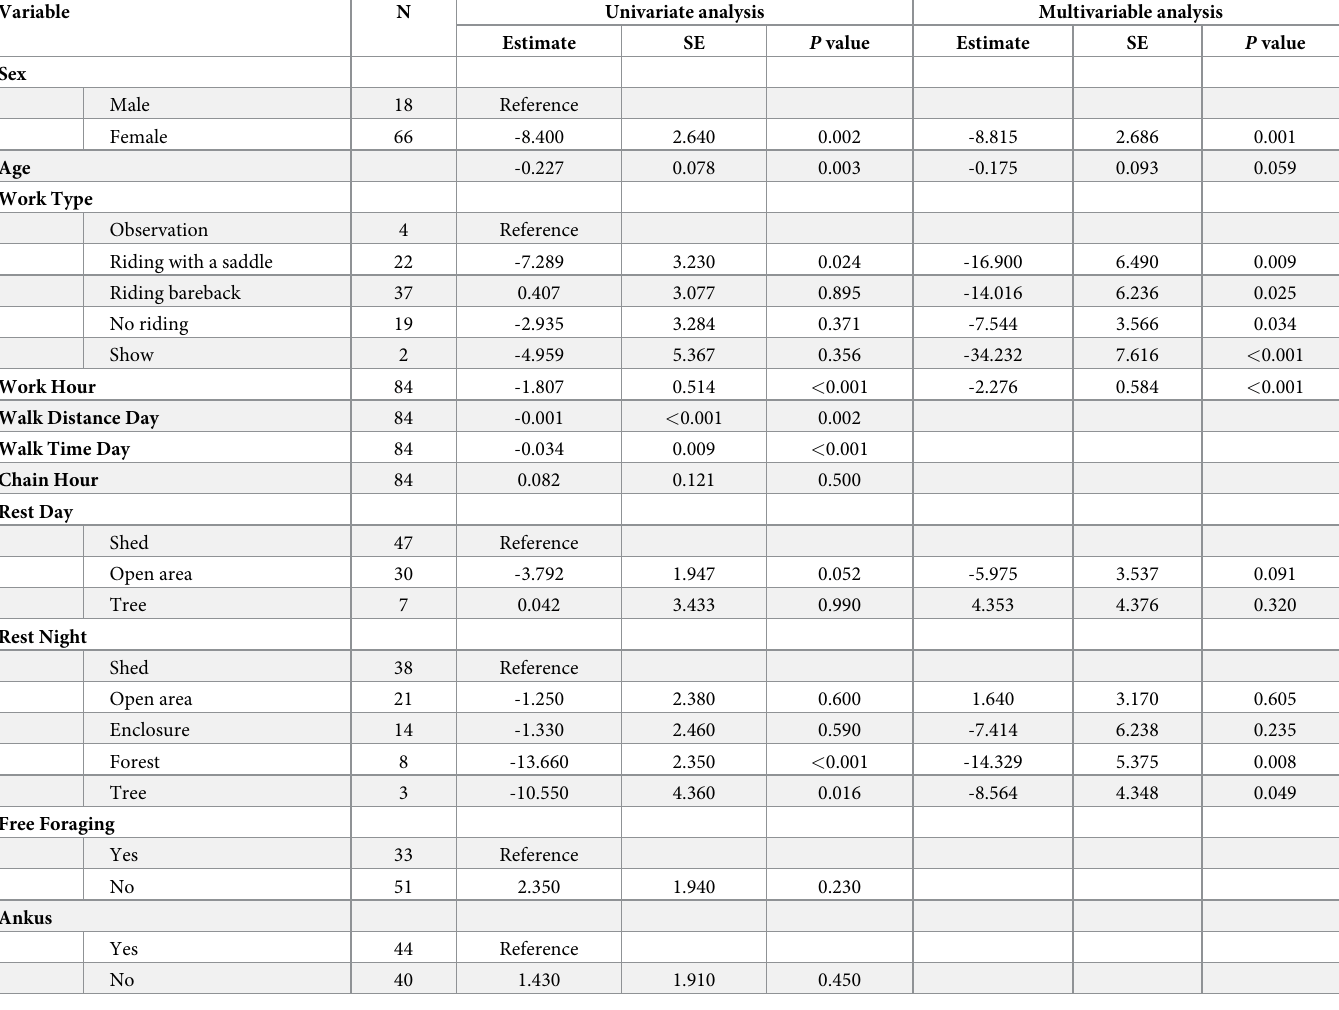
Table 4. Univariate and multivariable GEE analyses of demographic and management variables associated with fecal glucocorticoid metabolite (FGM)